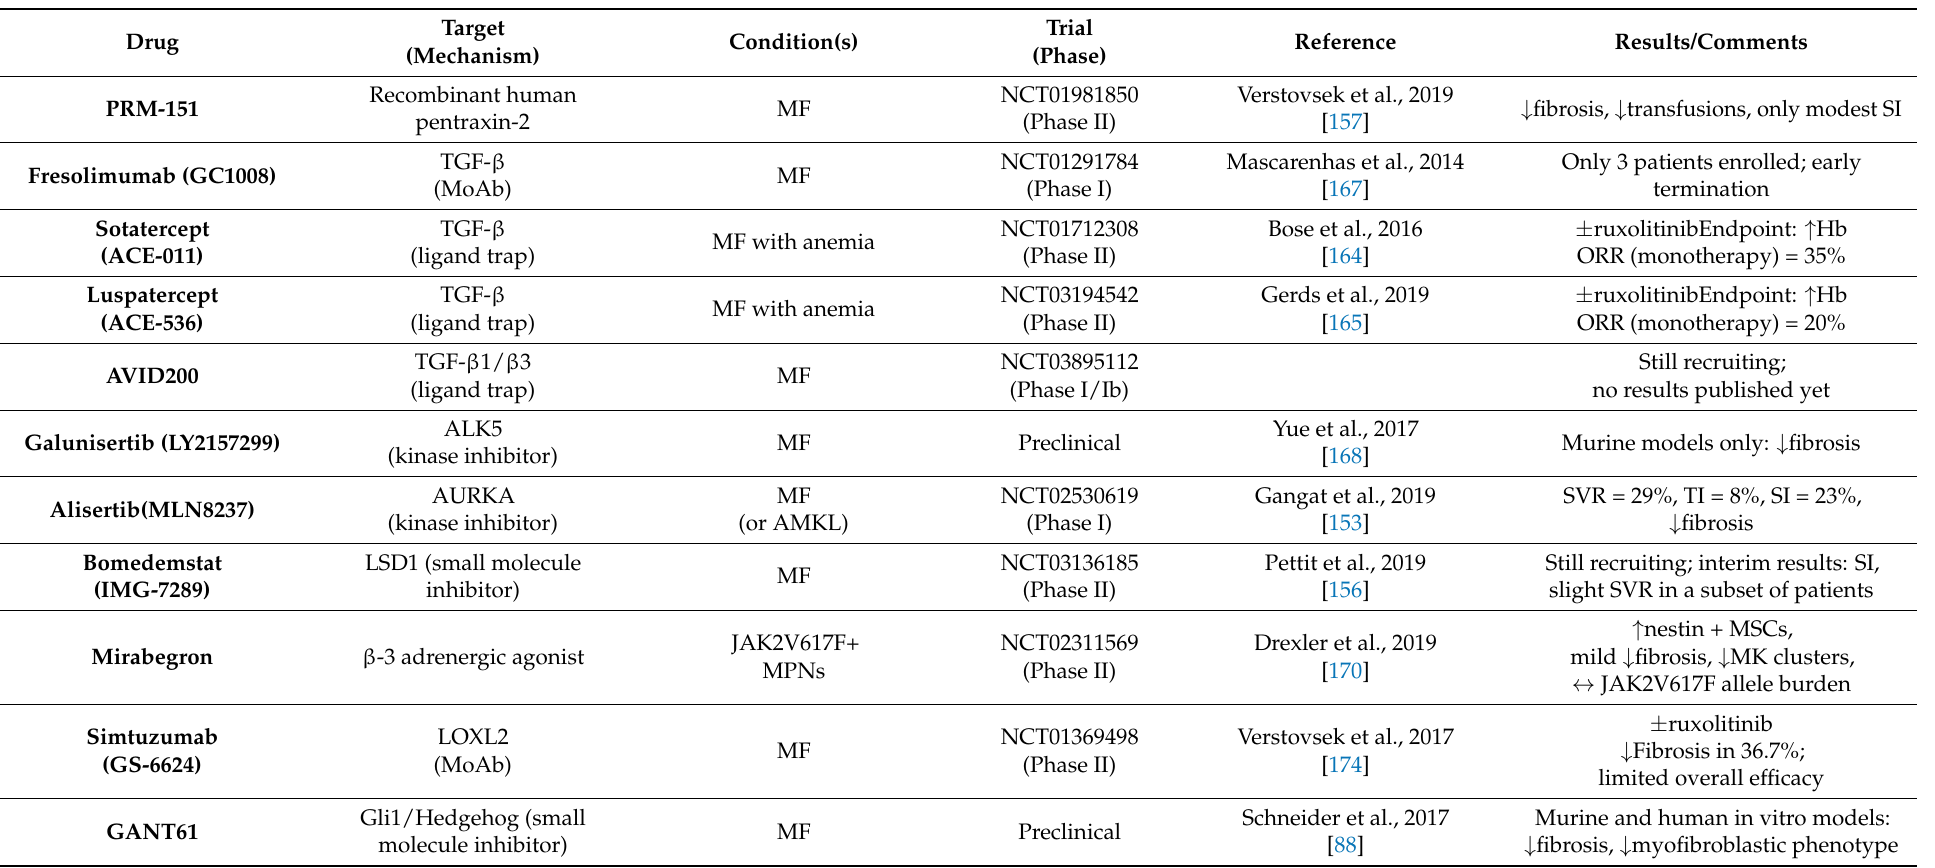
Table 1. Selected drugs targeting the MPN